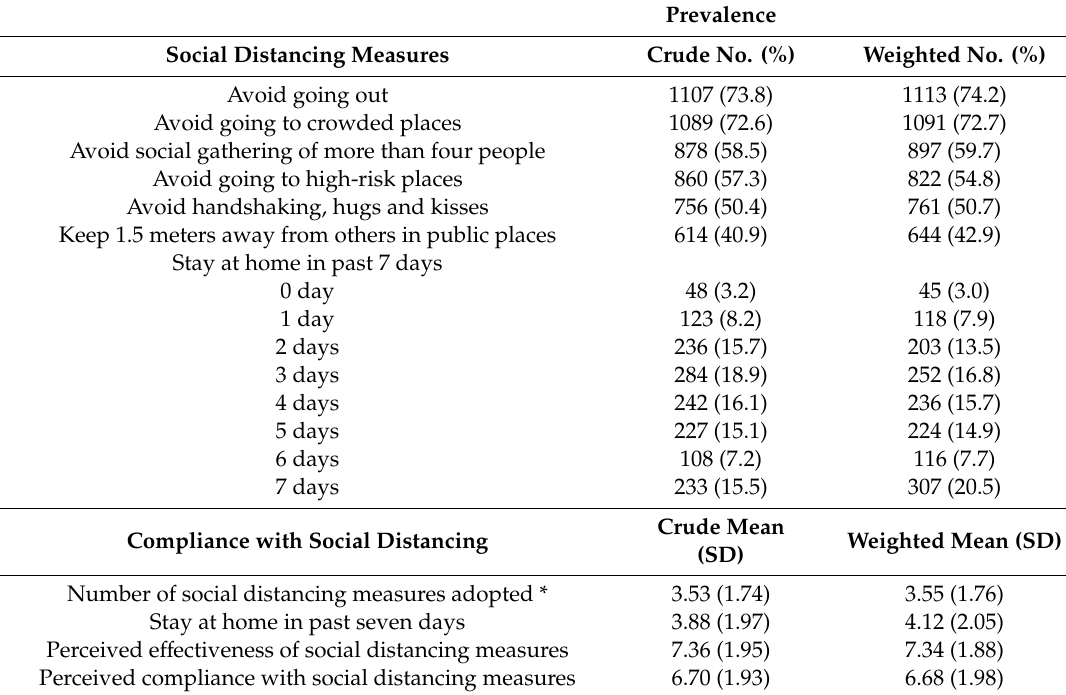
Table 2. Prevalence of social distancing measures and compliance.